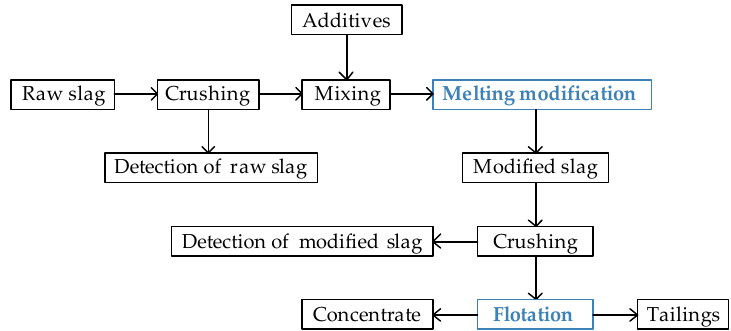
Figure 3. Melting modification – flotation test flowsheet of Cu slag.